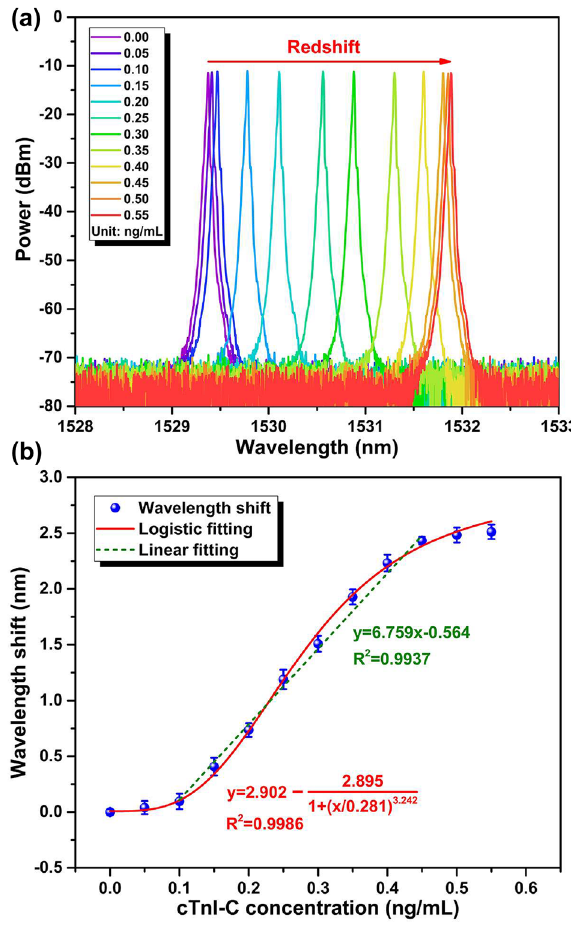
Figure 9: Experimental results of static response. (a) Spectrum evolution of the output sensing laser from the FRL with increasing cTnI-C concentration. (b) Response of the peak wavelength shift of the sensing laser to the cTnI-C concentration.